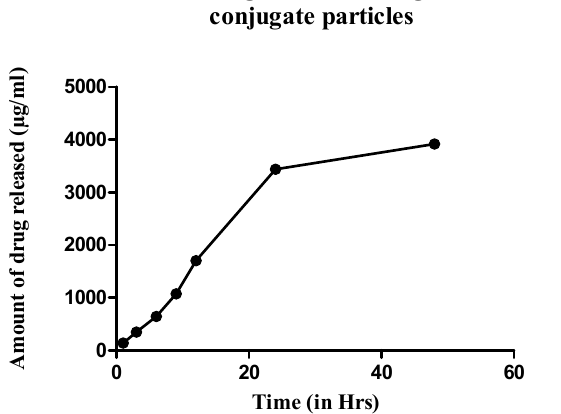
Figure 8. In vitro drug release profile of the drug-loaded conjugate nanospheres in the presence of bacterial media.